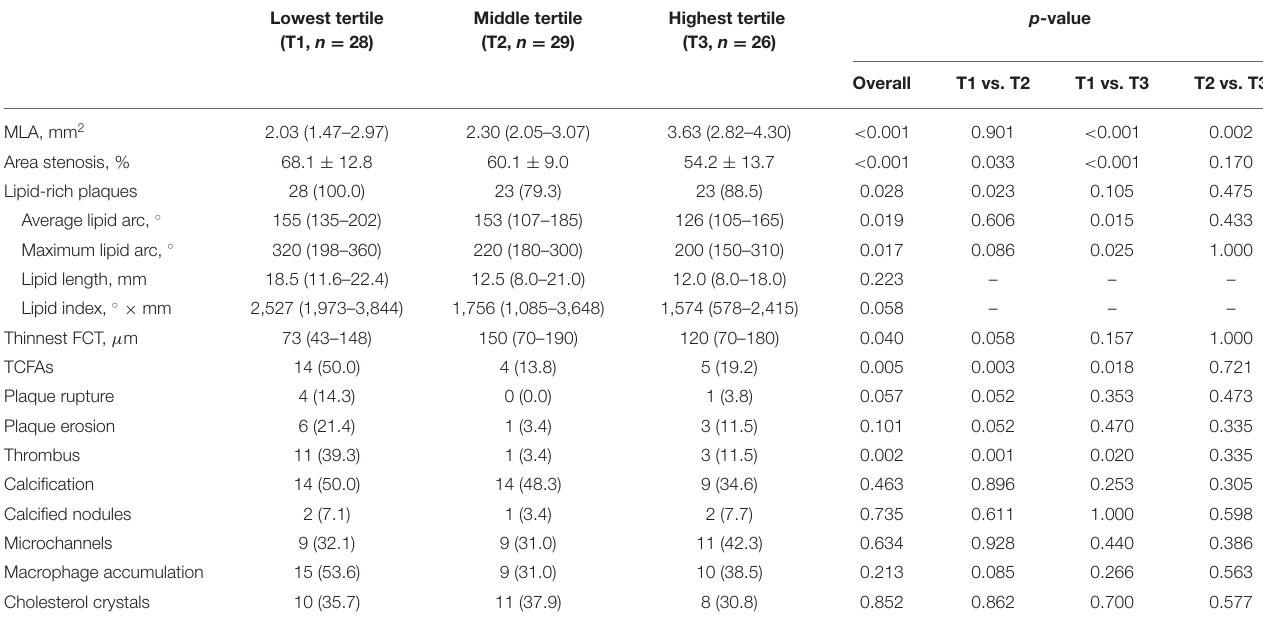
TABLE 2 | OCT characteristics according to QFR